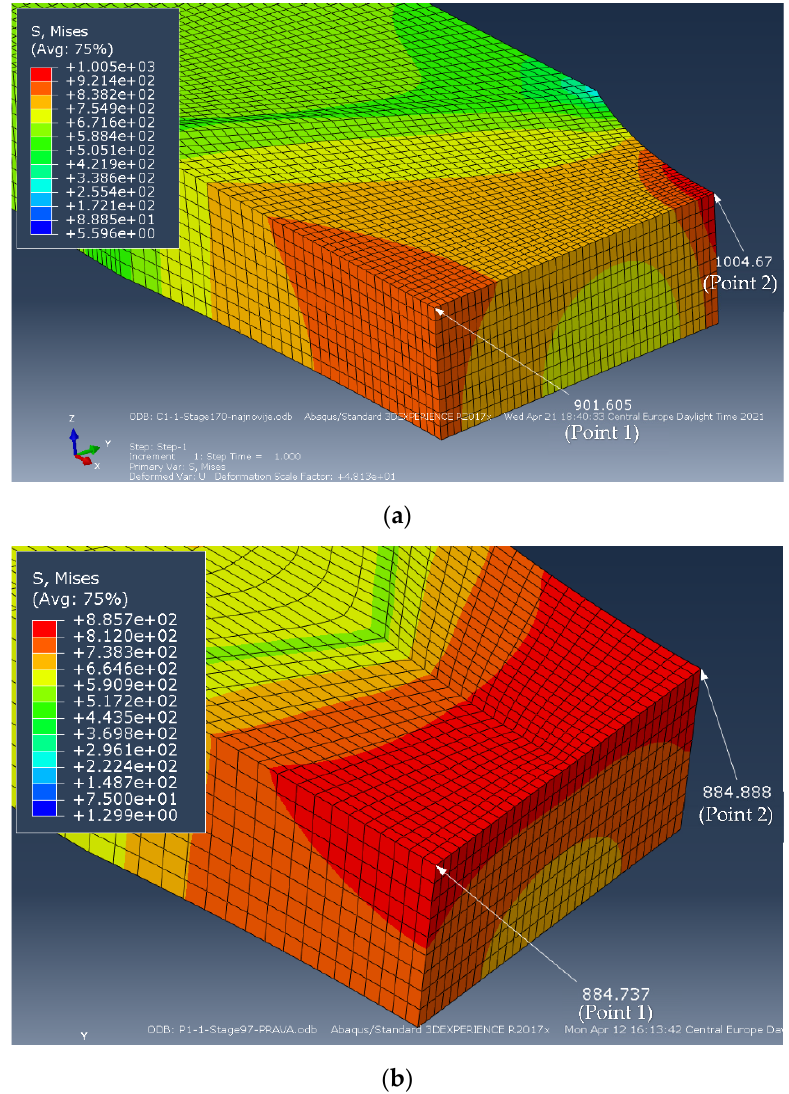
Figure 9. Maximum equivalent stresses in MPa at the characteristic points for specimens: ( a ) C1-1, ( b ) P1-1.